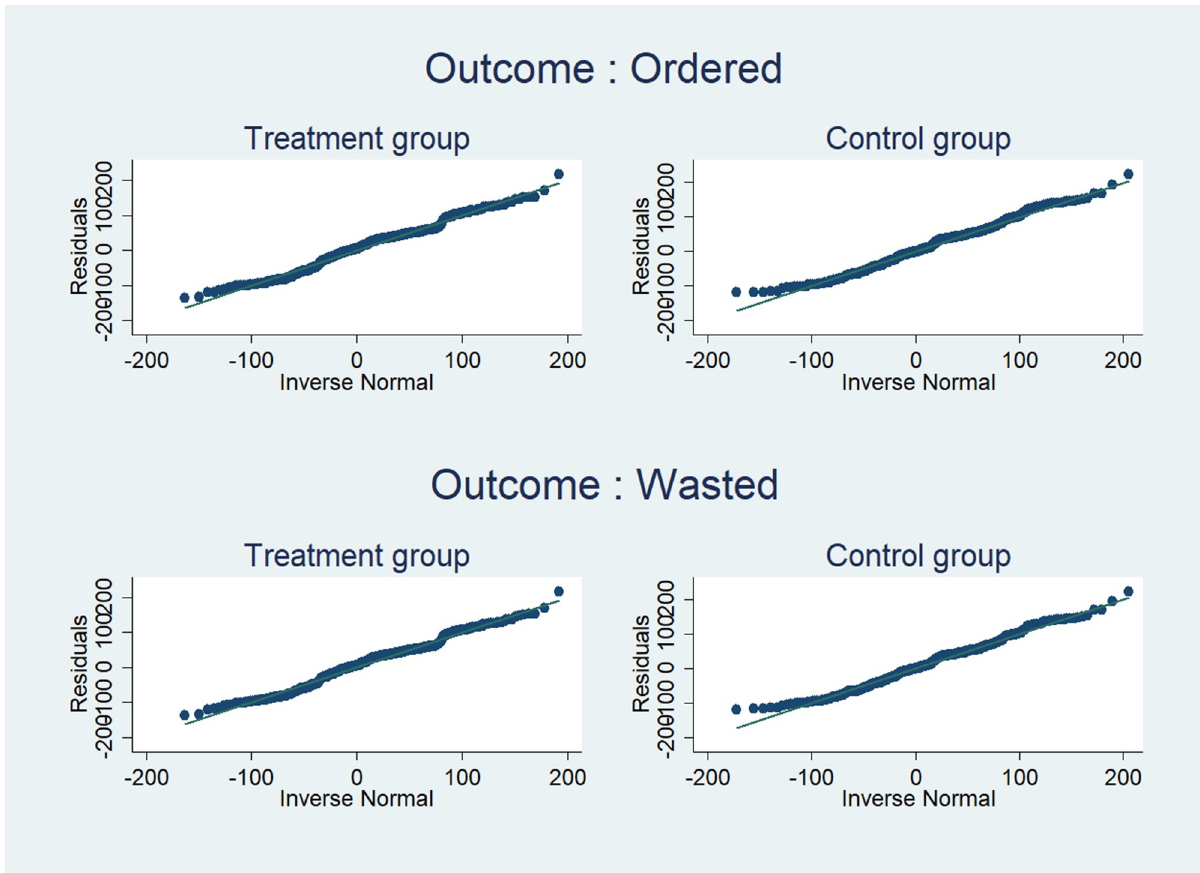
Fig 4. QQ-plots for both outcomes from the estimation results for Eq 1.